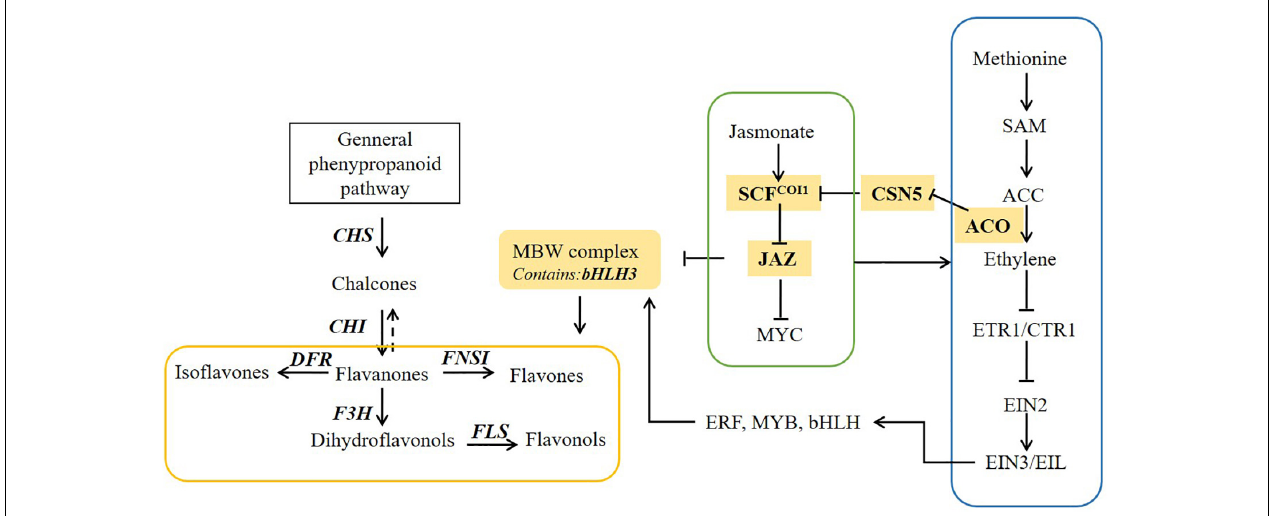
FIGURE 7 | The proposed pathway underlying ethylene and jasmonate (JA) pathway induced flavonoid biosynthesis in